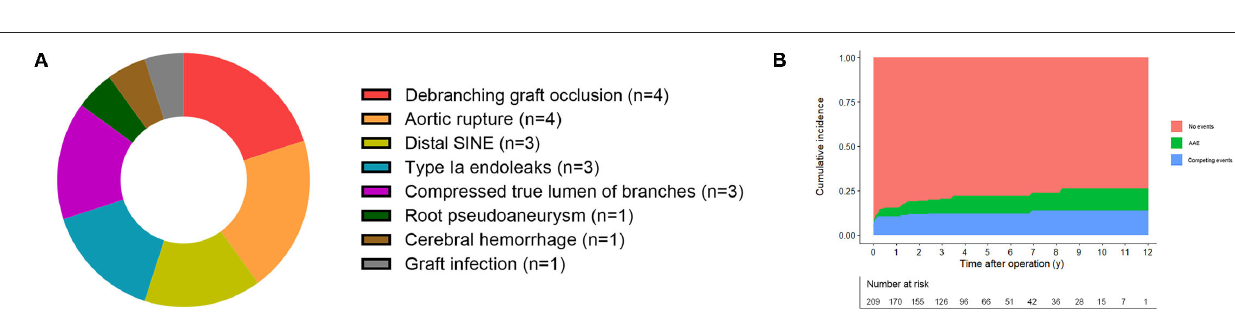
the 1, 5, and 10 years for the mild hypothermia group, which was similar to the 88.2, 83.9, and 79.9% for the moderate hypothermia group ( P =